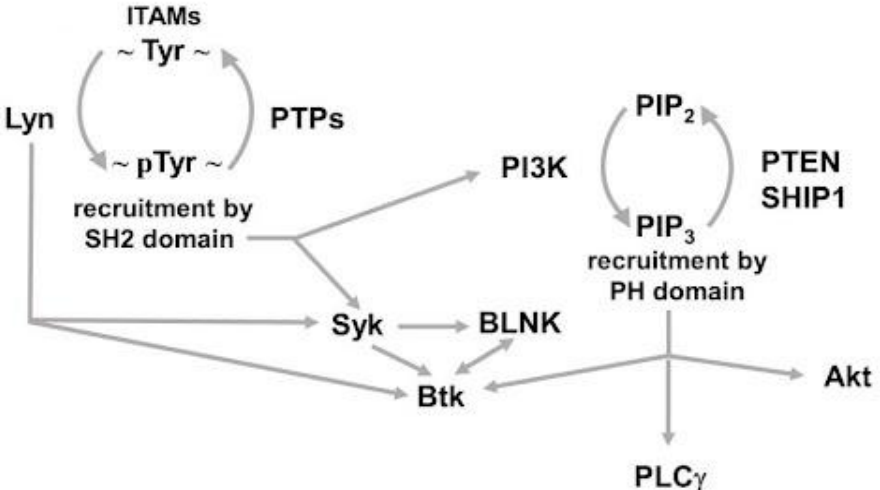
Figure 1. Schematic representation of the main events and mechanism of activation in the “signalosome” downstream of BCR. ITAM, immunoreceptor tyrosine-based activation motifs; pTyr, phosphotyrosine; PTP, protein tyrosine phosphatase; PI3K, phosphoinositide-3-kinase; PIP2, phosphatidylinositol (4,5)-bisphosphate; PIP3, PI(3,4,5)-trisphosphate (PI(3,4,5)P3); PTEN, Phosphatase and tensin homolog; SHIP1, Src homology 2 (SH2) domain containing inositol polyphosphate 5-phosphatase 1; PLC γ , phospholipase C γ ; BLNK, B cell linker.